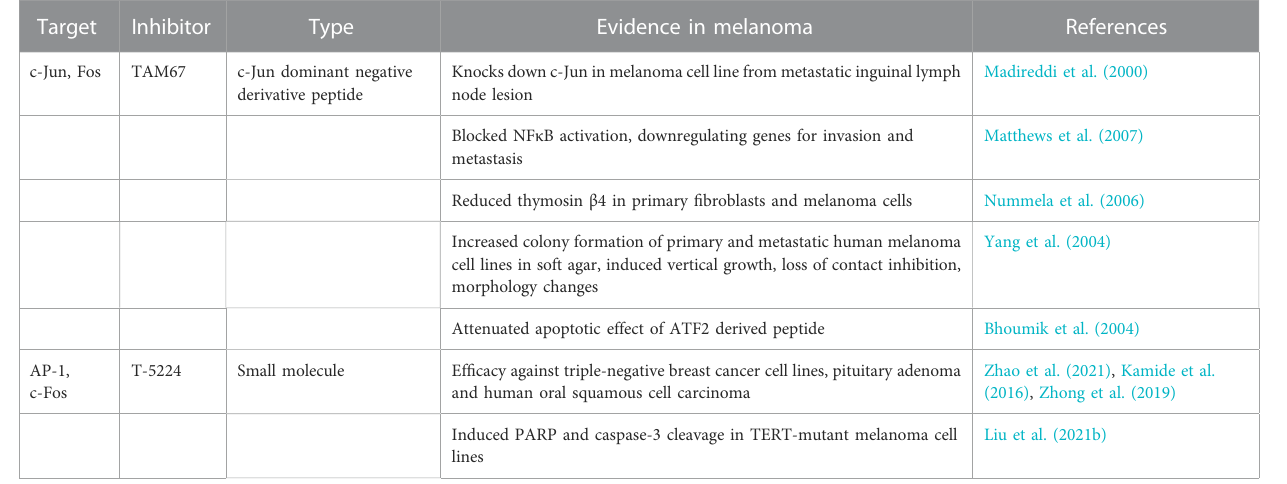
TABLE 6 AP-1 family inhibitors.